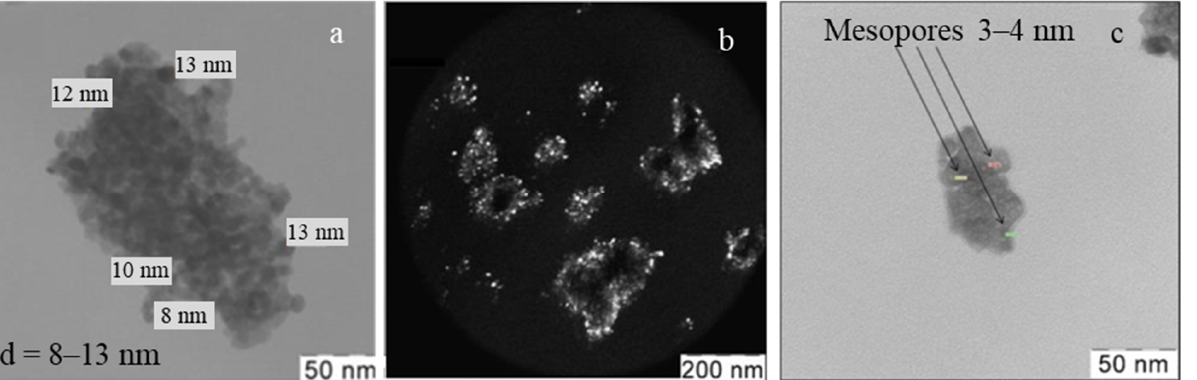
Figure 4. XRD pattern and phase composition, as well as the crystallographic data for the zirconia nanopowder (inset).